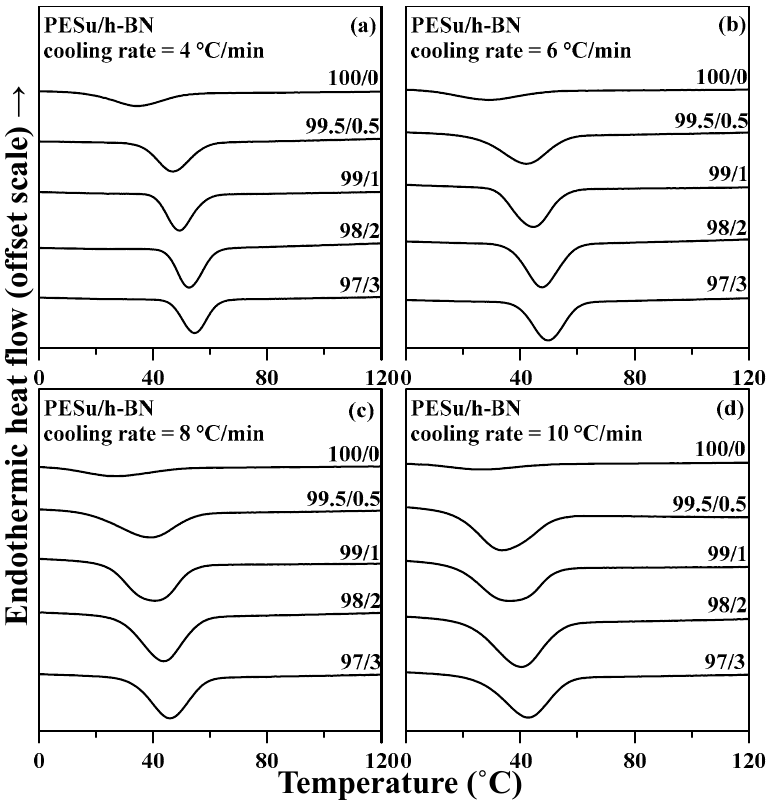
Figure 7. Non-isothermal crystallization thermograms of PESu/h-BN composites when the cooling Figure 7. Non ‐ isothermal crystallization thermograms of PESu/h ‐ BN composites when the cooling rates are: ( a ) 4 ◦ C/min; ( b ) 6 ◦ C/min; ( c ) 8 ◦ C/min; and ( d ) 10 ◦ rates are: ( a ) 4 °C/min; ( b ) 6 °C/min; ( c ) 8 °C/min; and ( d ) 10 °C/min. Table 2. Non ‐ isothermal crystallization parameters calculated by the Mo model for various PESu/h ‐ BN composites.